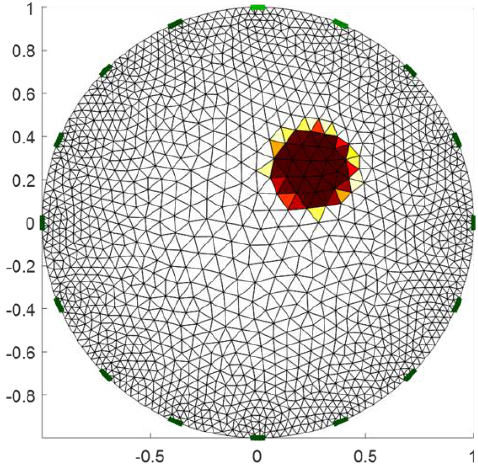
Figure 2. Simulated phantom sample.